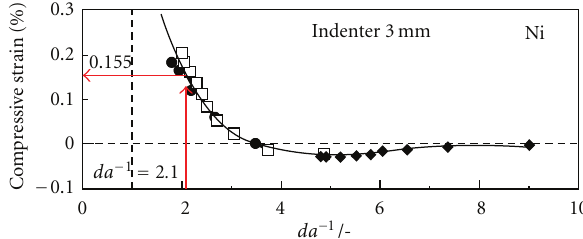
Figure 10: Compressive strain distribution against relative distance d/a in quasistatic for pure